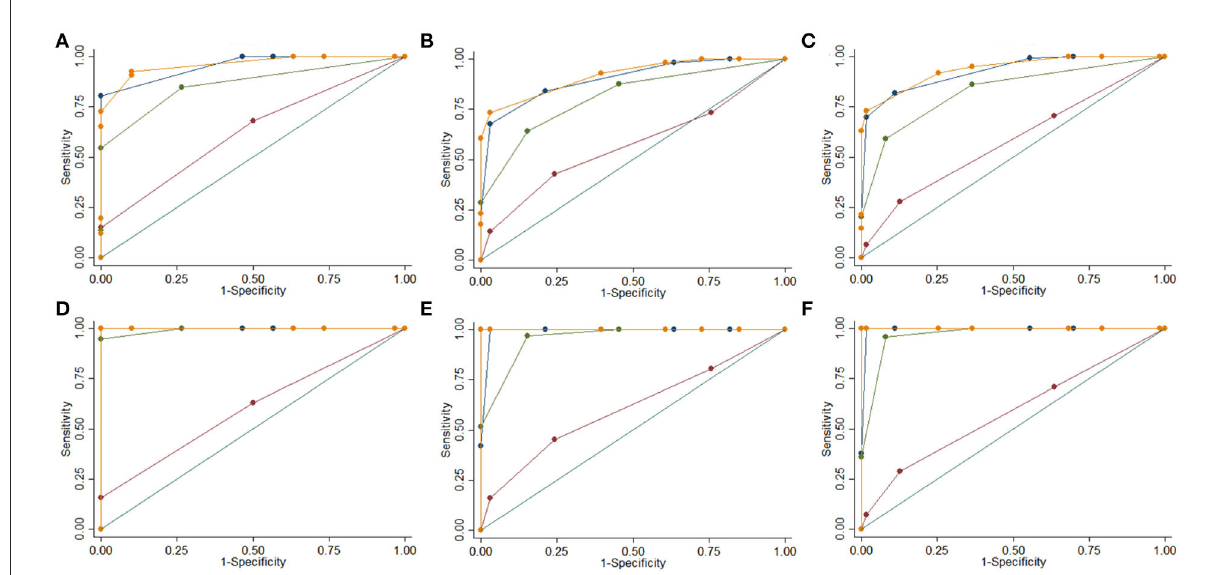
FIGURE2 ROC Curves for different MRI visual rating scales. MTA Non-Adjusted (Blue), WMH (Brown), PA (Green), MTA + PA (Orange). Control vs. prodromal AD or AD 75 or under 75 (A) , over 75 (B) , all ages (C) ; Control vs. AD 75 or under 75 (D) , over 75 (E) , all ages (F) .